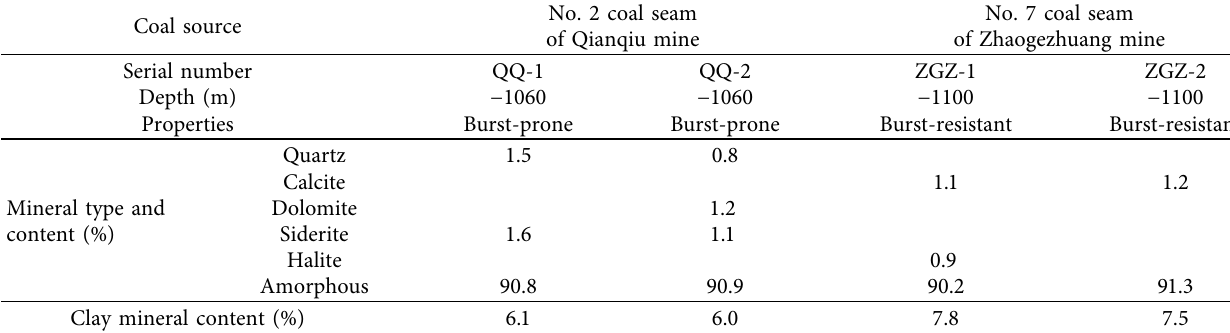
Table 2: Analysis of coal specimens through the XRD method.